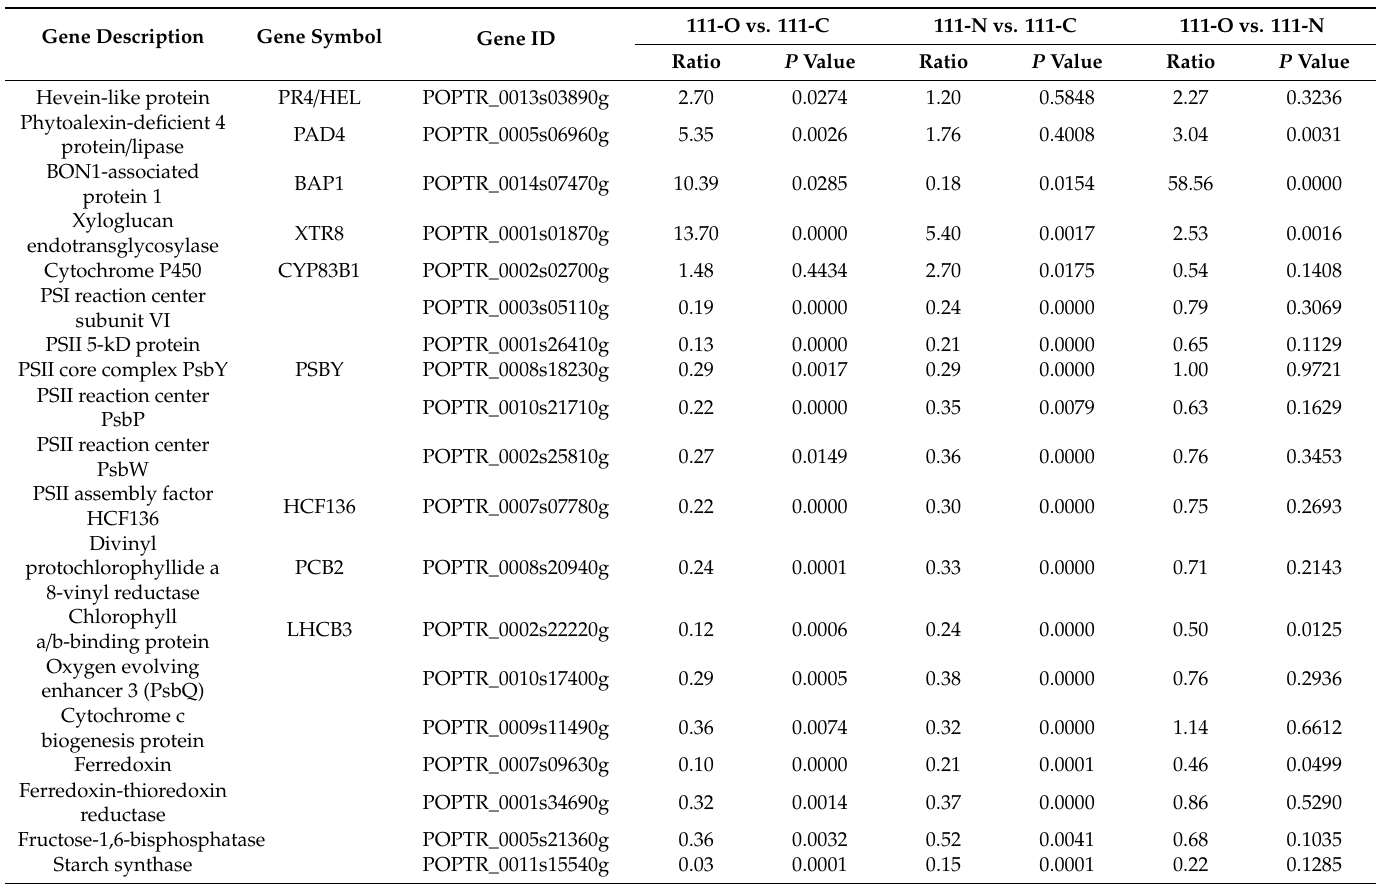
Table 4. Di ff erential gene expression of important defense genes among the ‘111’ treatment